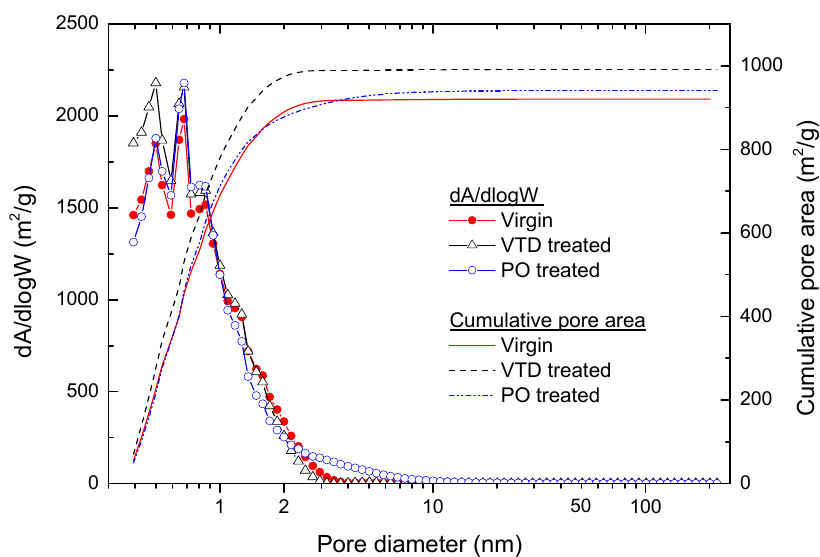
Figure 4. Pore volume distribution of virgin, VTD (vacuum thermal desorption) treated and PO (partial oxidation) treated spent GAC samples as a function of the pore diameter estimated by the NLDFT method.